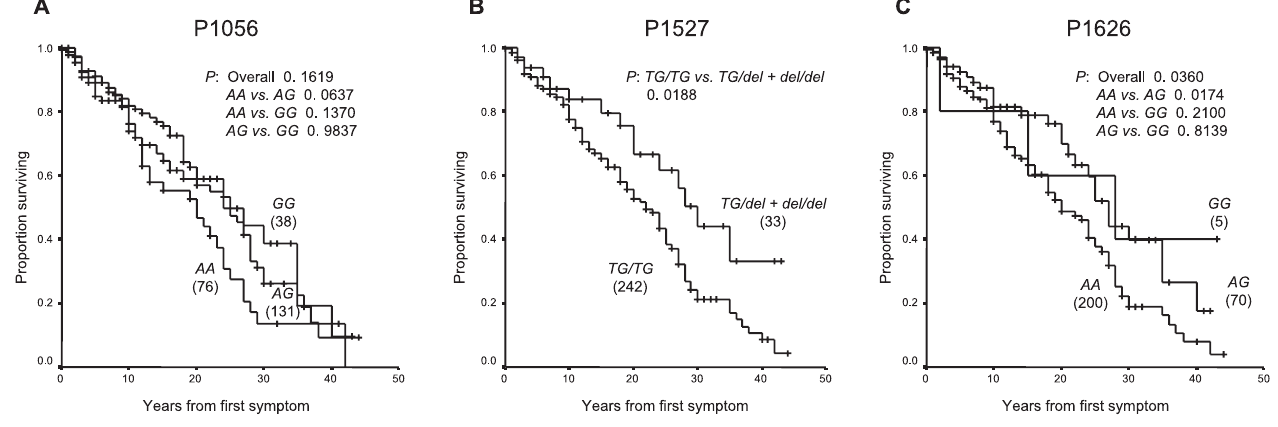
Figure 3. Kaplan-Meier Curves for Overall Survival by CD24 Polymorphisms among OSU MS Patients (A) No significant difference was found in the survival rate among patients with the P1056 genotype. (B) Patients carrying the variant P1527 del allele had a higher survival rate than those who had two copies of the wild-type P1527 TG allele. (C) Patients with the P1626 AA genotype had a lower survival rate than those with the P1626 AG or P1626 GG genotype. Numbers in parentheses are the size of samples for MS patients. Forty-five percent of the MS patients have reached EDSS 6.0.